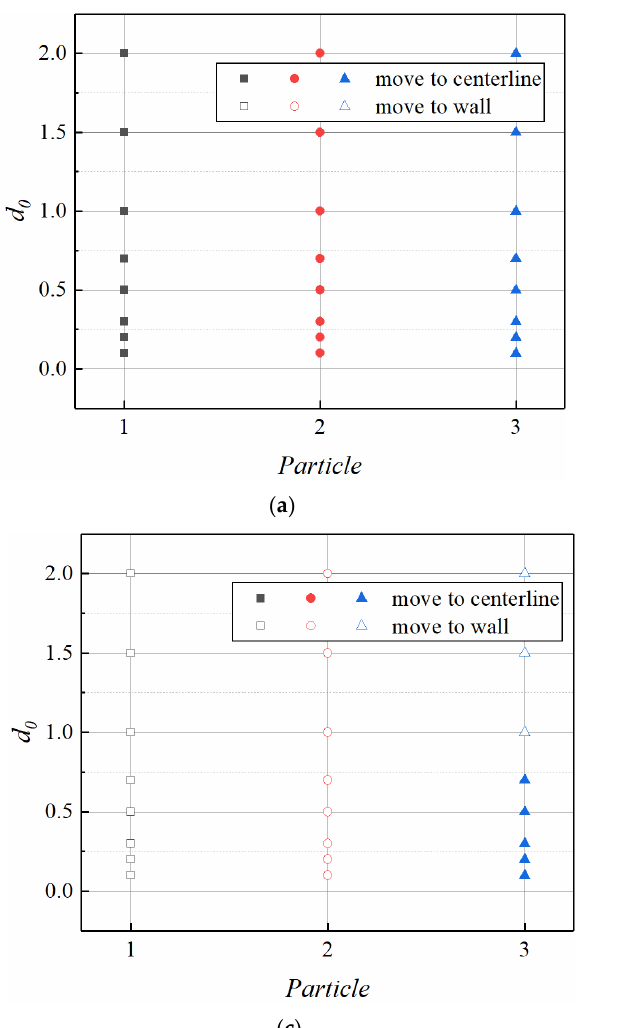
0.5, η r = 0.3, ε = 0.3, y 0 = 0.2) ( a ) α = 0.1; ( b ) α = 0.3; ( c ) α = 0.5; ( d ) α = 0.7.